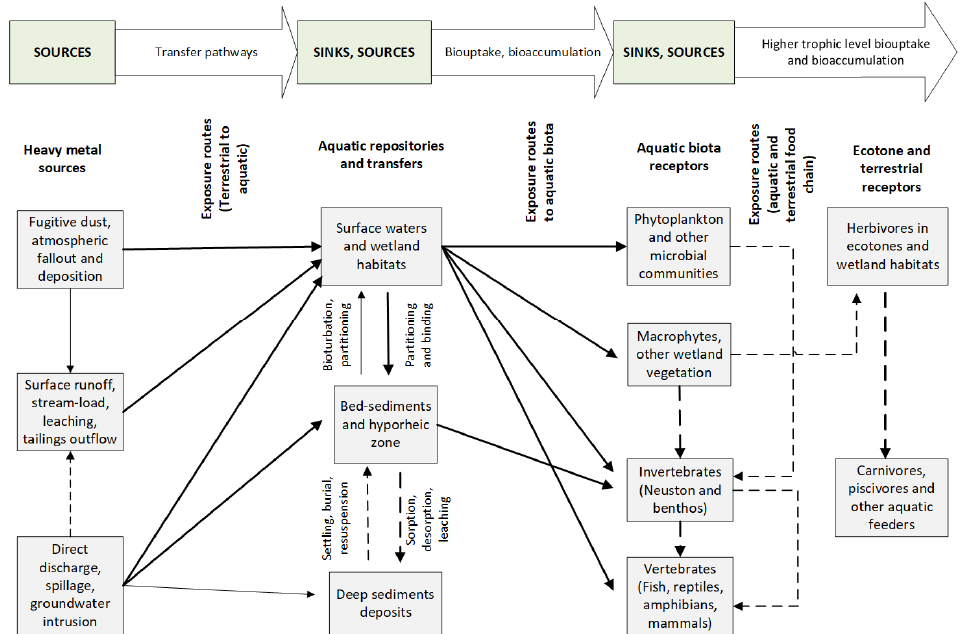
Figure 3. Conceptualised exposure pathways of aquatic biota to heavy metal pollution in surface and ground waters draining mining landscapes. The arrow density directly correlates to the importance of the respective exposure pathway. Based on the interplay between biotic and environmental components, the model is developed from the contaminant exposure concept in Giddings et al.